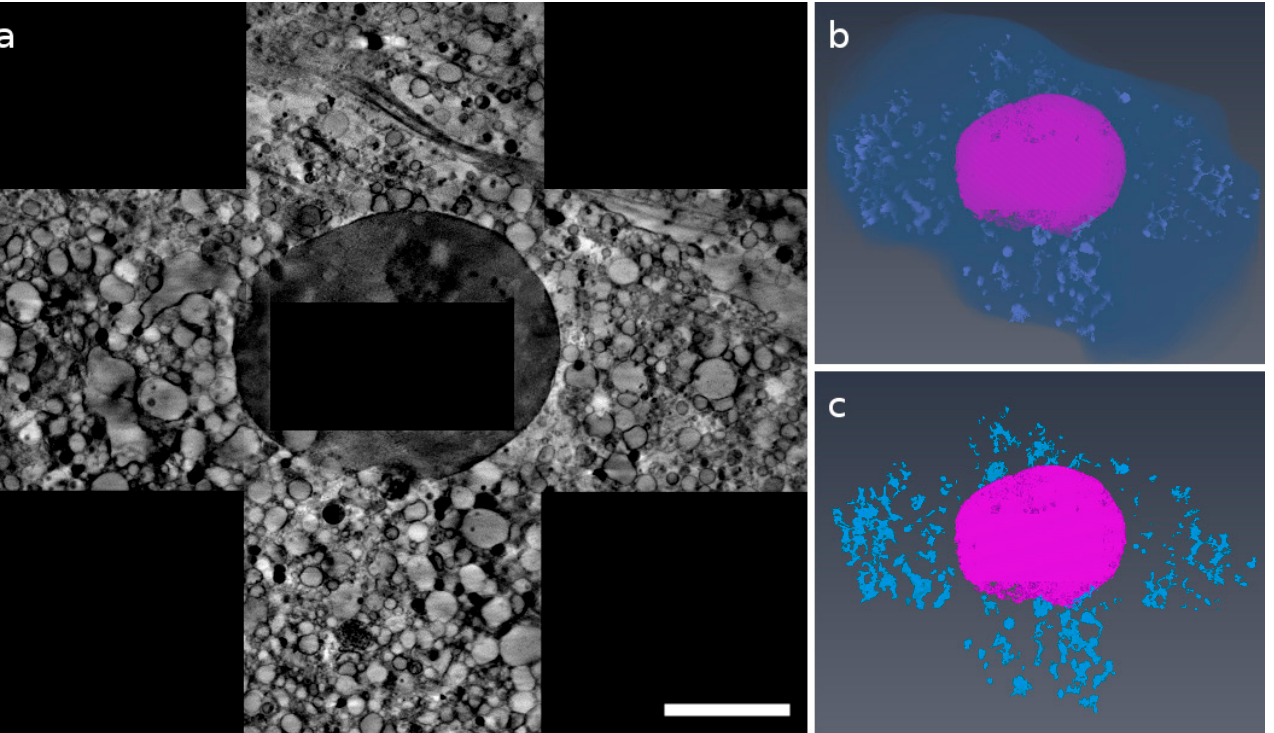
Figure 1. ( a ) Central slice of a bMSC-4D cell volume collected at 520 eV and obtained by stitching together four tomographic reconstructions. Scale bar is 6.9 μ m. ( b , c ) Corresponding color-coded 3D rendering (with the nucleus in pink and the dense objects inside the cell in light blue). These objects are different in shape and dimensions and were automatically selected using a threshold. In ( b ), the cellular membrane is also showed.